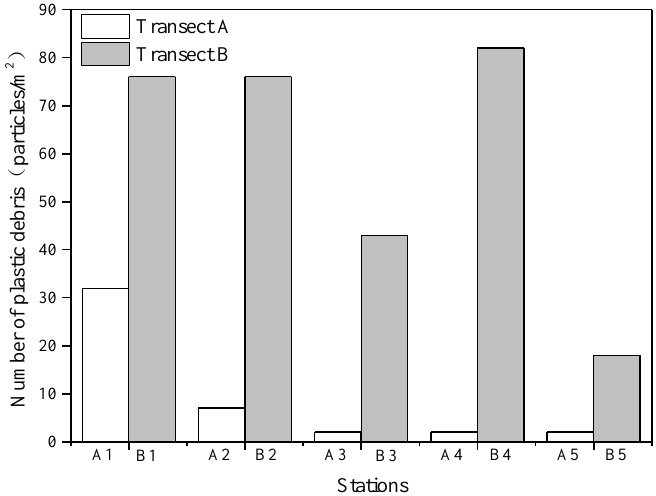
Figure 3. Spatial distribution of plastic debris along the land-based source wastewater discharge outlet.